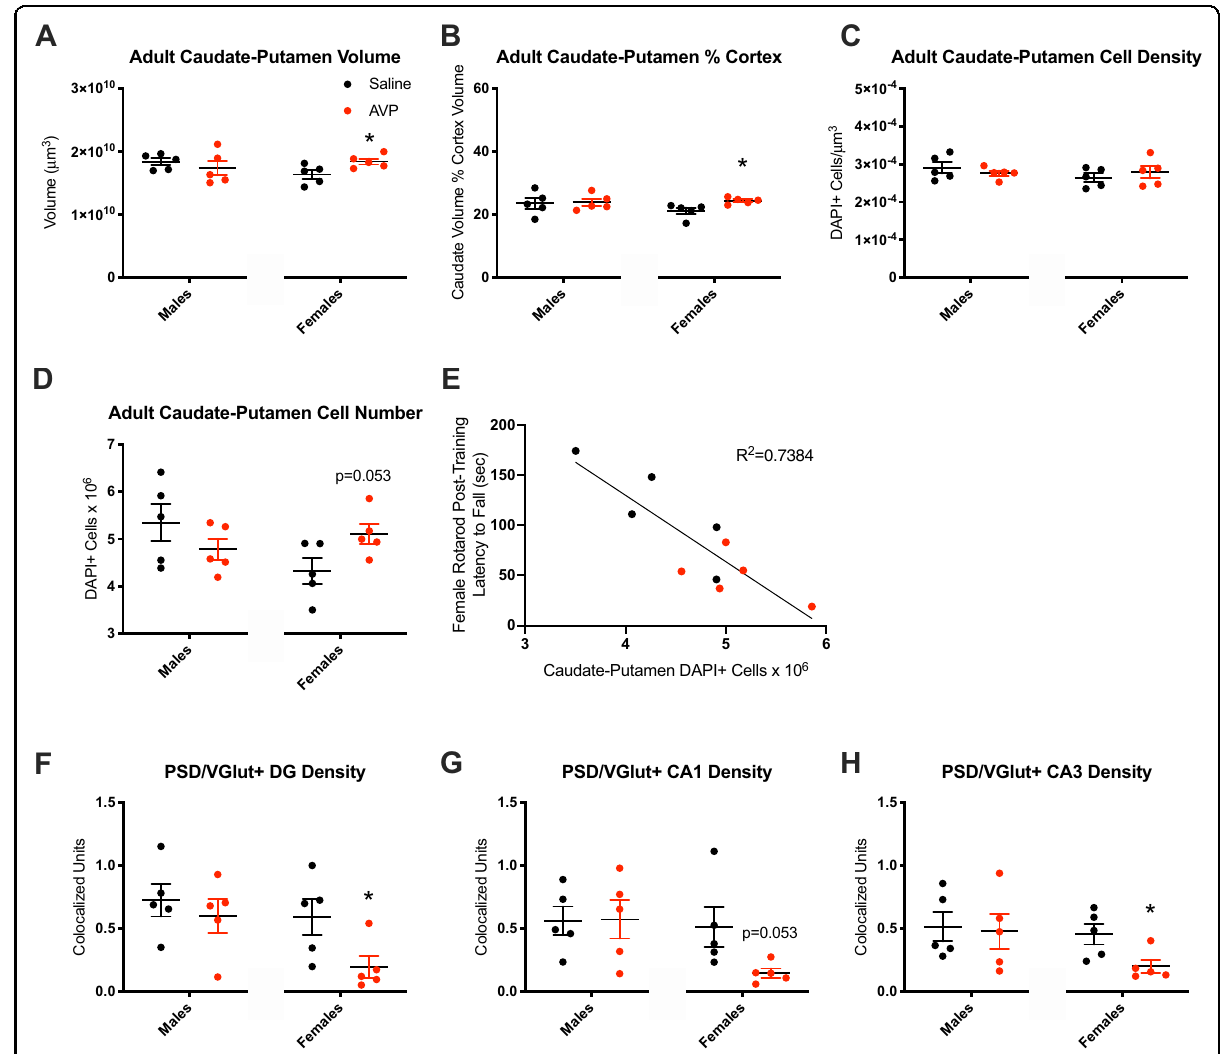
Fig. 2 Adult offspring neurobiology was altered by maternal AVP. a AVP-exposed females had increased caudate – putamen volume ( p = 0.037), ( b ) as well as increased caudate – putamen volume relative to cortex volume ( p = 0.021). c Caudate – putamen cell density was unchanged. d The number of cells in the caudate – putamen was trend-increased in AVP-exposed females ( p = 0.053). e Caudate – putamen cell numbers were inversely correlated with post-training rotarod performance in adult female offspring ( R = − 0.6809; p = 0.0014 by exploratory analyses; q = 0.0056 after Benjamini – Hochberg FDR correction). f Excitatory synapse density (PSD95/VGlut1 colocalization) was decreased in the DG in AVP-exposed females ( p = 0.046), and ( g ) trend-decreased in the CA1 ( p = 0.053) and decreased in the ( h ) CA3 ( p = 0.030) regions. * p < 0.05 per two-sample t -test, error bars represent SEM. 2 – 3 litters per condition, 1 – 3 brains per sex per